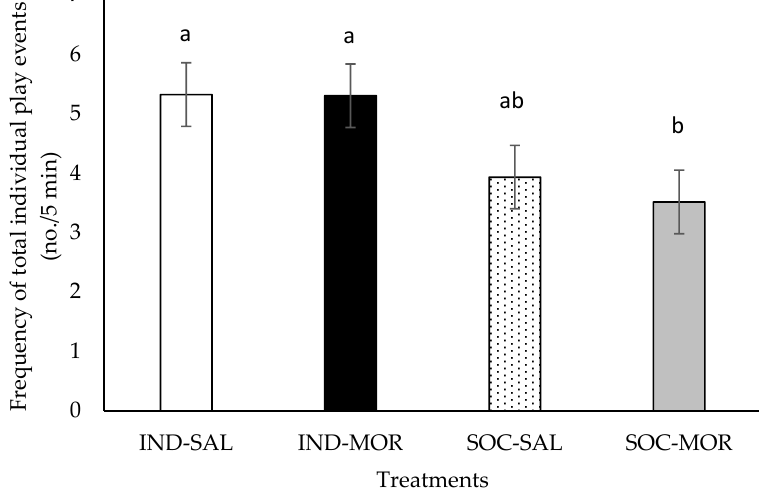
Figure 3. Frequency (no./5 min; Least square means ± SEM) of total individual play events performed by calves during a 20 min observation period in an arena test. Calves received an injection of saline and were tested individually (IND-SAL, n = 12) or in pairs (SOC-SAL, n = 12), or received an injection of morphine and were tested individually (IND-MOR, n = 12) or in pairs (SOC-MOR, n = 12). Least square means with different superscripts differ at p ≤